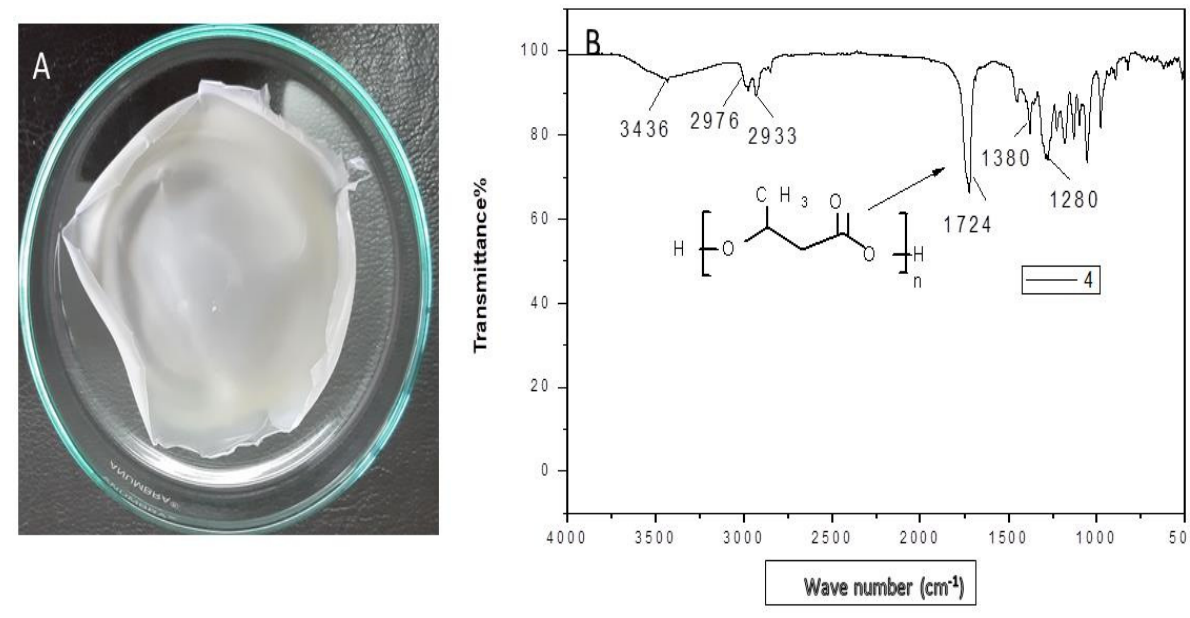
Figure 3. ( A ) PHB film and ( B ) FTIR analysis of PHB extracted from Bacillus wiedmannii